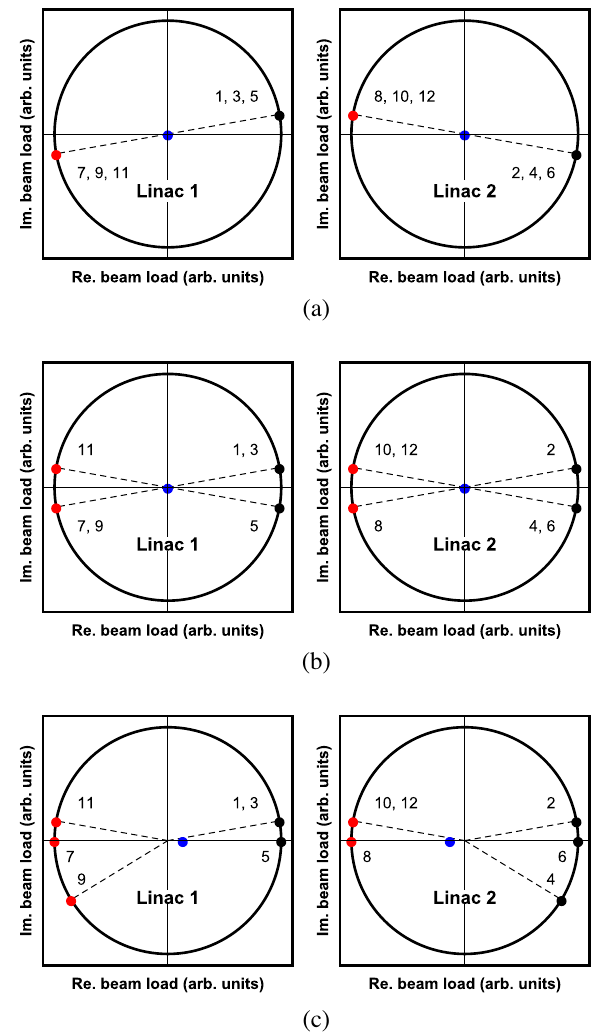
FIG. 6. rf beam load plots for different phase configurations in common transport longitudinal matches that minimize beam energy spread. Applicable to, e.g., PERLE. rf phase choices during acceleration (black), deceleration (red), and resulting beam load (blue) of each linac independently. Number labels indicate the ordering of the rf passes. (a) minimal phase changes, (b) multiple phase changes and (c) rf imbalance between linacs. crest and the second linac equally far behind crest, Fig. 6(a).